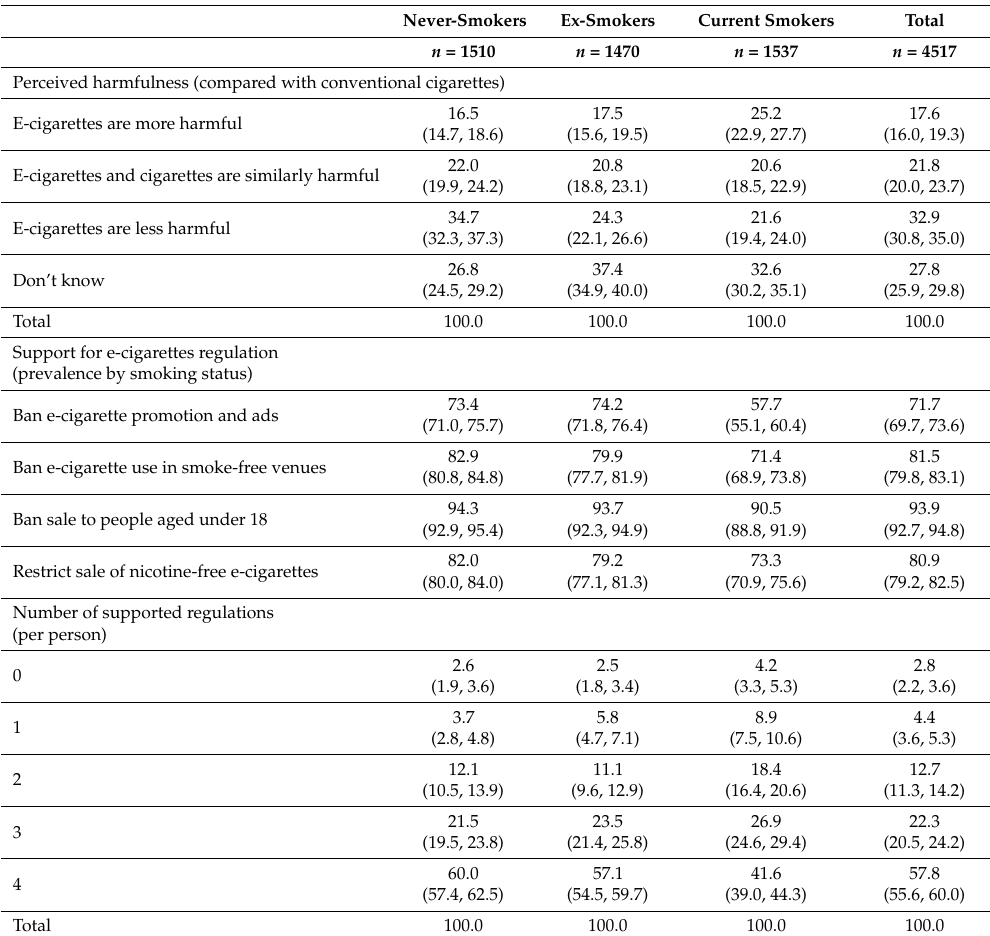
Table 3. Perception towards e-cigarettes, and support for e-cigarette regulation, by smoking status in respondents who had heard of e-cigarettes, weighted % (95%